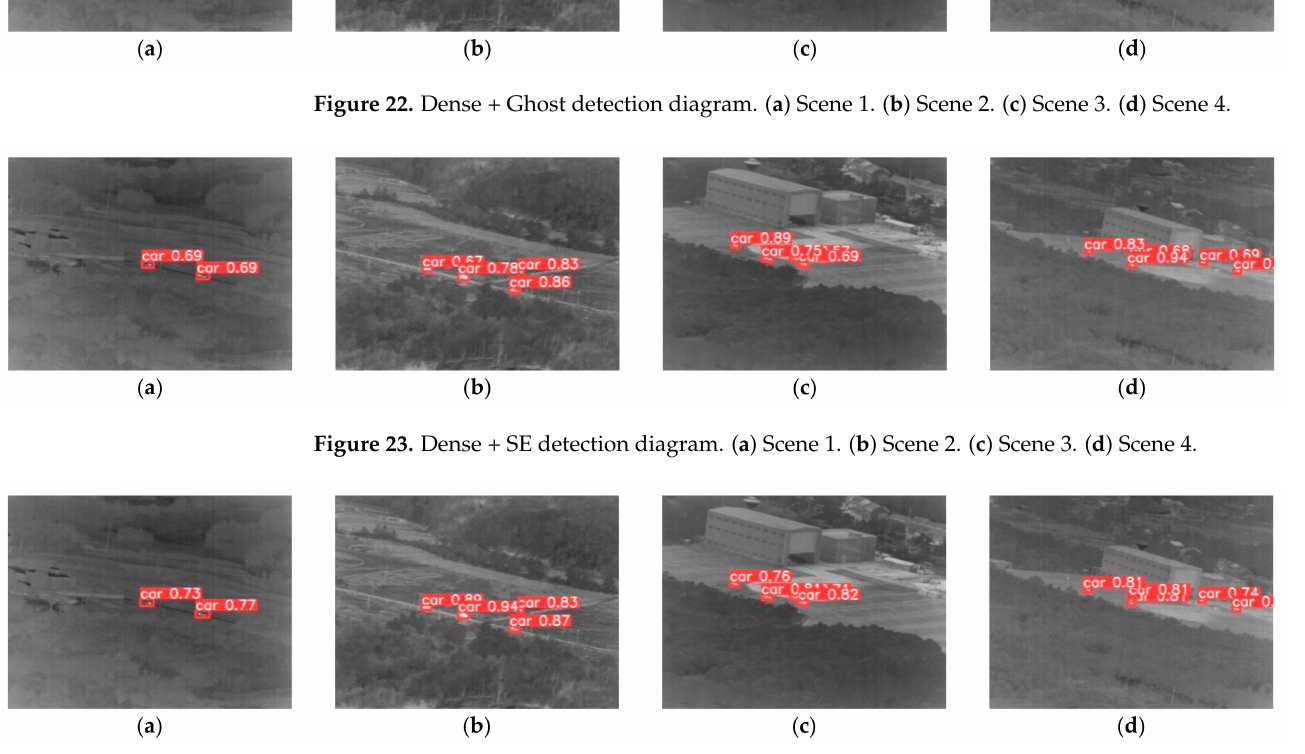
Figure 24. Dense + Ghost detection diagram. ( a ) Scene 1. ( b ) Scene 2. ( c ) Scene 3. ( d ) Scene